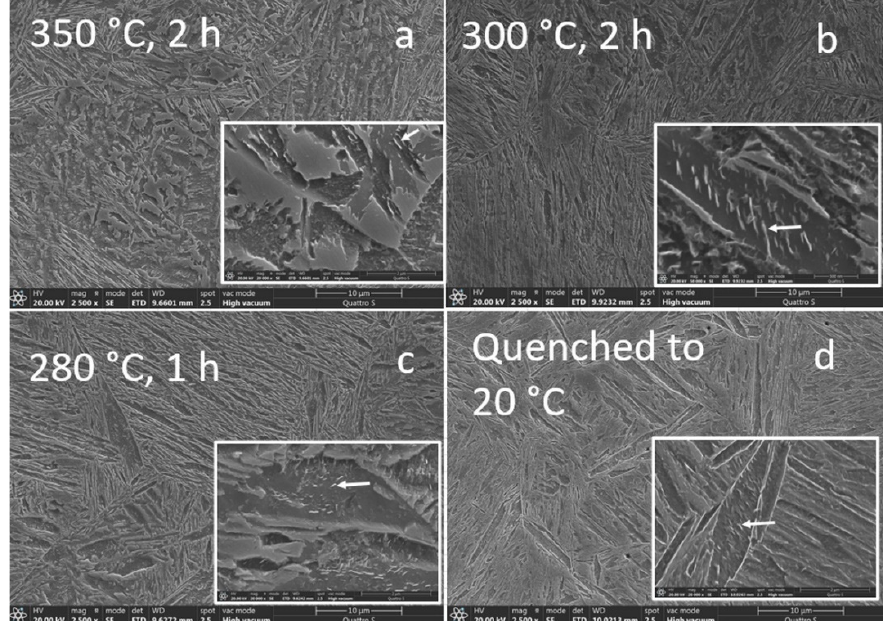
Figure 9. SEM of the dilatometric samples with marked carbides, heat treated according to the heat treatment cycle presented in Figure 1.